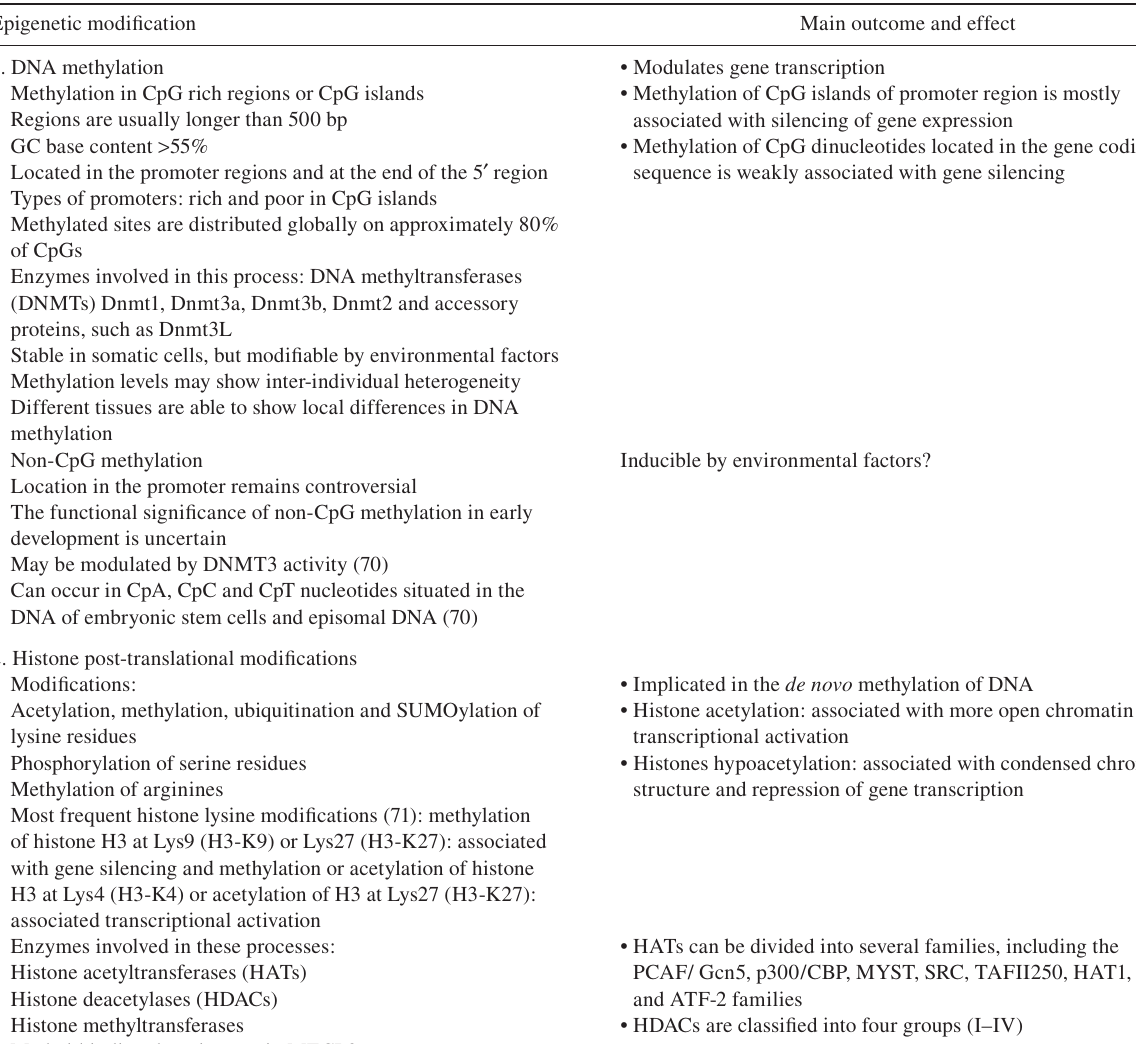
Table 1 Epigenetic modifi cations: a brief